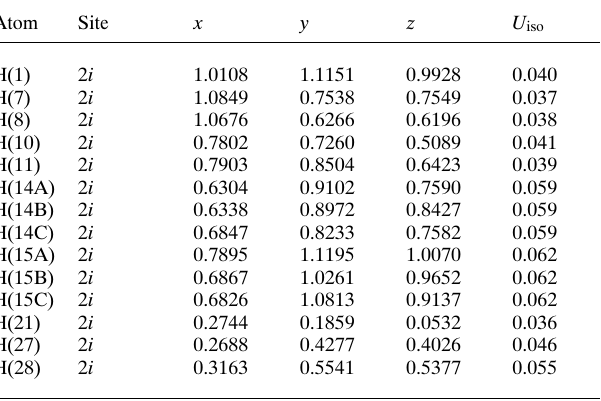
Table 2. Atomic coordinates and displacement parameters (in Å 2 ) .